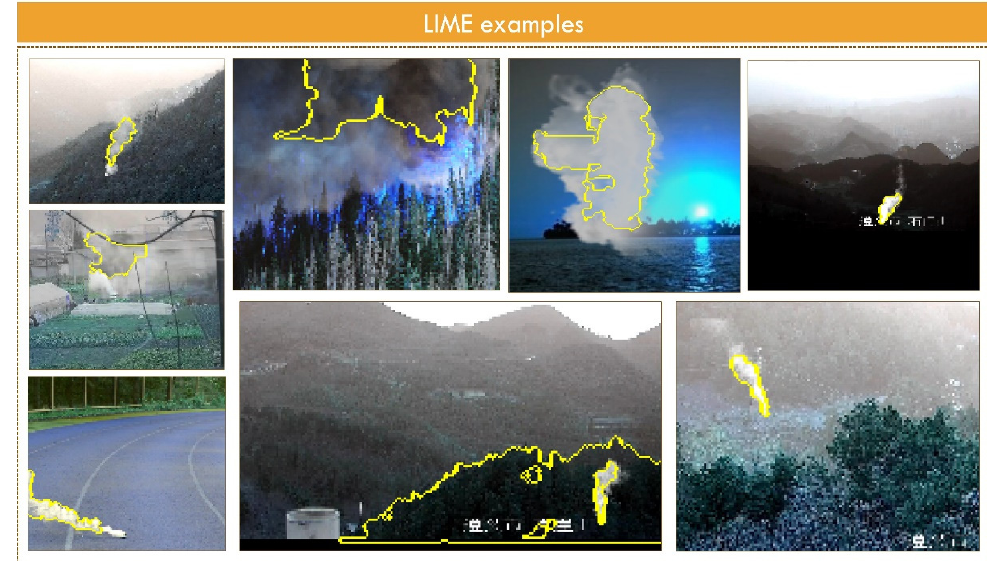
Figure 4. Random samples produced by LIME applied to Xception CNN. LIME draws a yellow segmentation area around the most significant location according to the model.